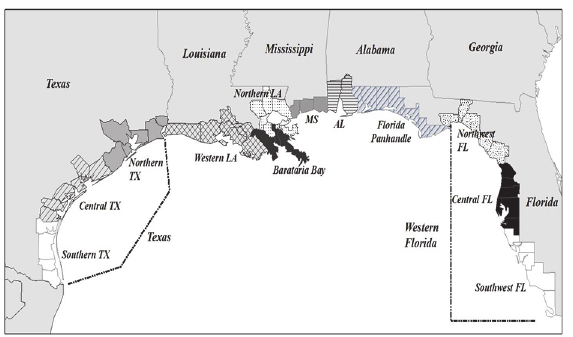
Fig 1. Map of the U.S. Gulf Coast showing county groups used in analysis of regional monthly baseline common bottlenose dolphin ( Tursiops truncatus ) stranding numbers. Baselines for Texas and Western Florida were determined by combining multiple regions outlined below. Gulf Florida includes the Florida Panhandle and the Western Florida combined region.